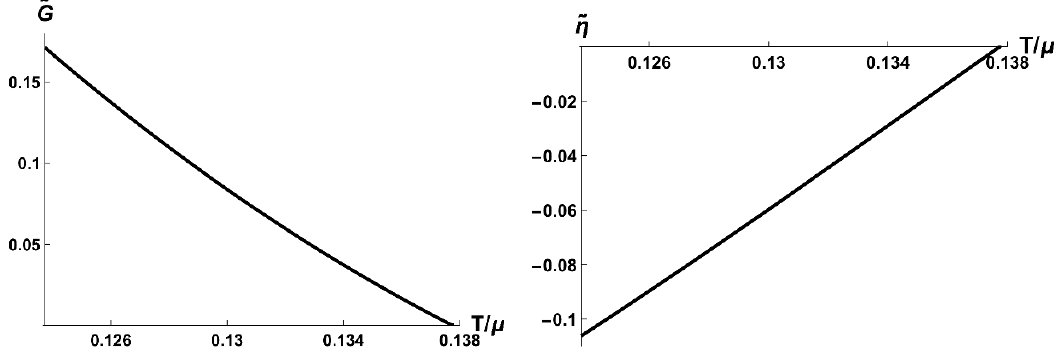
Figure 6 . The reduced shear elastic modulus ~ G = 16 (cid:25)G N G=k 4 (left panel) and the reduced shear viscosity ~ (cid:17) = (4 (cid:25)(cid:17)= S (cid:0) 1) (right panel) as a functions of k=T for select values of T f red ; green g curves, at the criticality.